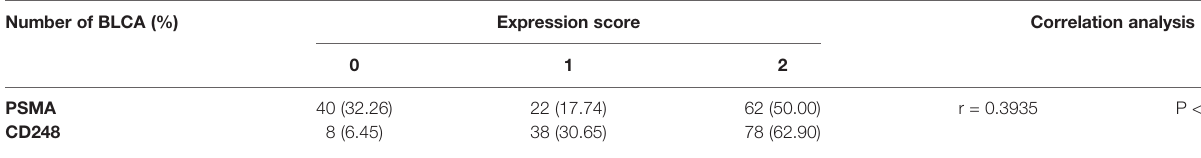
TABLE 2 | Expression of PSMA and CD248 in tumor-associated vasculature of UCB patient s (n = 124). Number of BLCA (%) Expression score Correlation